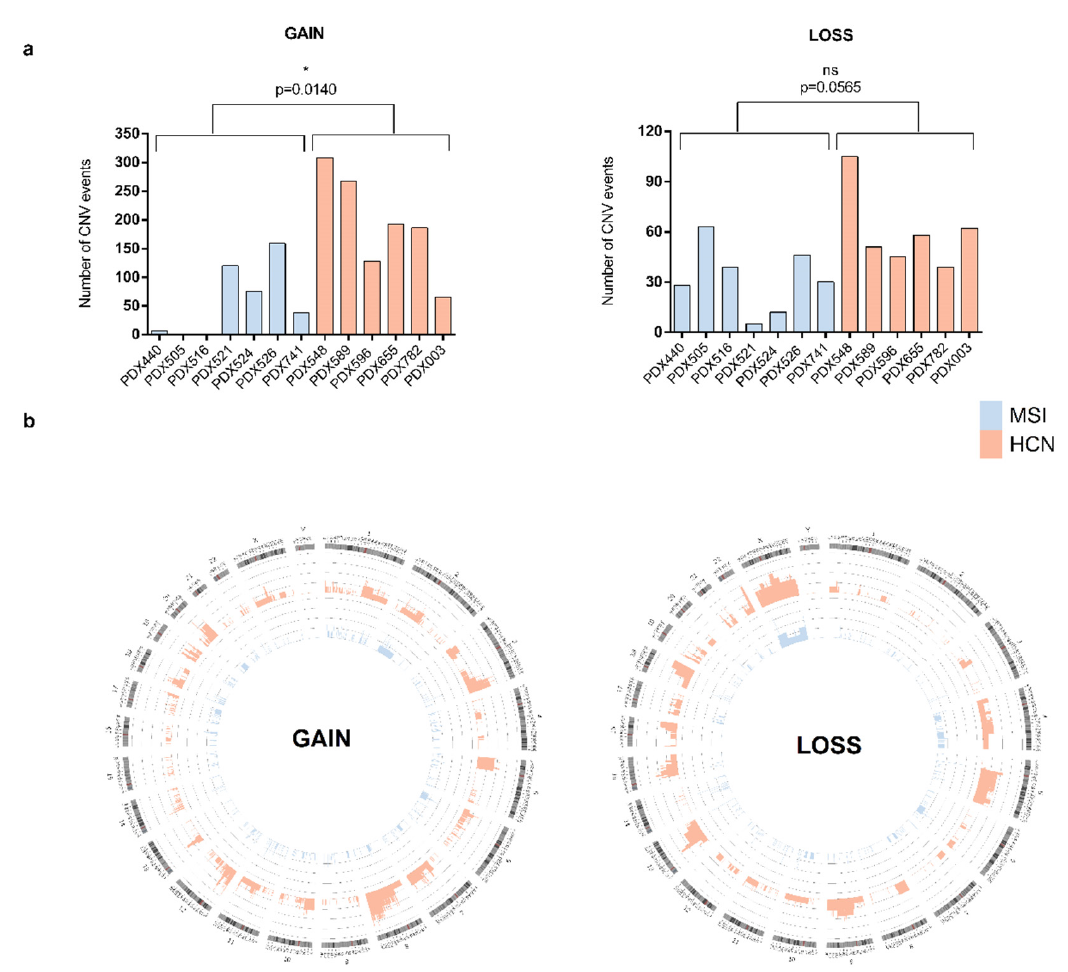
Figure 3. Molecular characterization of PDX models based on copy-number variants. ( a ) Comparative analysis of the total number of CNV events in each PDX model, grouped as MSI and HCN. Left panel shows the number of genes included in CNV GAIN events, while right panel reveals the number of genes included in CNV LOSS events. ( b ) Circos representation of the frequency and genomic distribution of CNV GAIN ( left panel ) and LOSS ( right panel ) events for each PDX group, MSI (blue, inner circle) vs. HCN (orange, outer